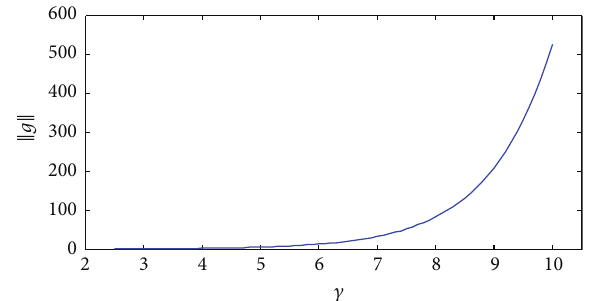
Figure 7: The 𝐿 2 -norm of 𝑔 for different 𝛾 ( 𝛾 ∈ [2.5,10] , ‖𝑔‖ = (∫ 1 |𝑔(𝑥)| 2 𝑑𝑥) 1/2 ). 0